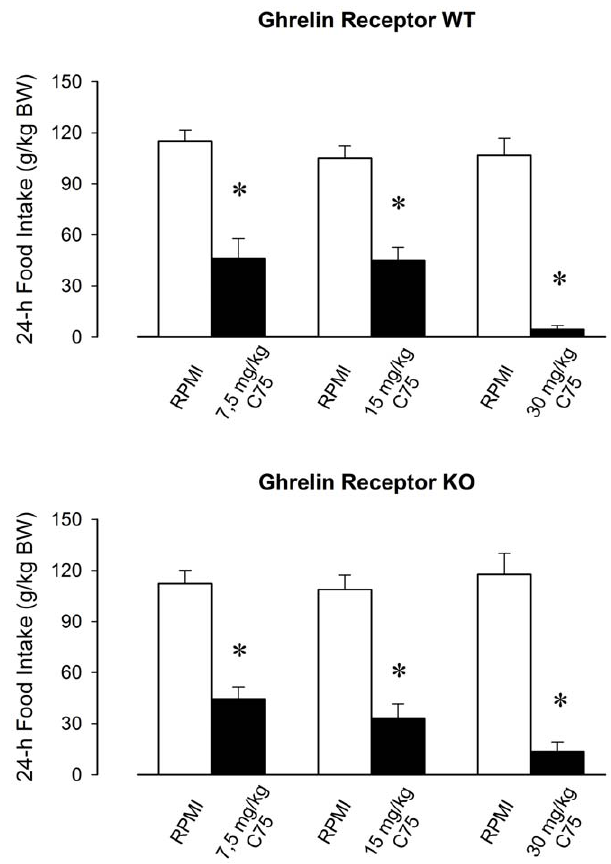
Figure 4. Daily food intake after vehicle (white bars) and 7.5, 15 and 30 mg/kg C75 (black bars) injections in ghrelin receptor WT and KO mice. Asterisks denote significant differences between control and treatment days (paired t-test). All doses of C75 significantly suppressed 24-h food intake. There was no significant difference in the effect of C75 between the two genotypes.